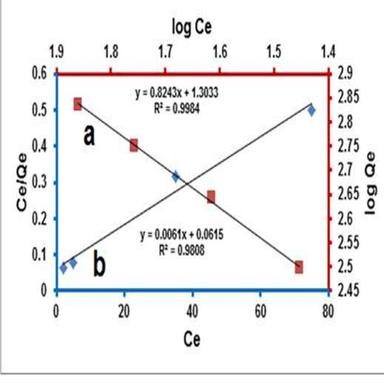
(a) Freundlich adsorption (b) Langmuir adsorption isotherm.